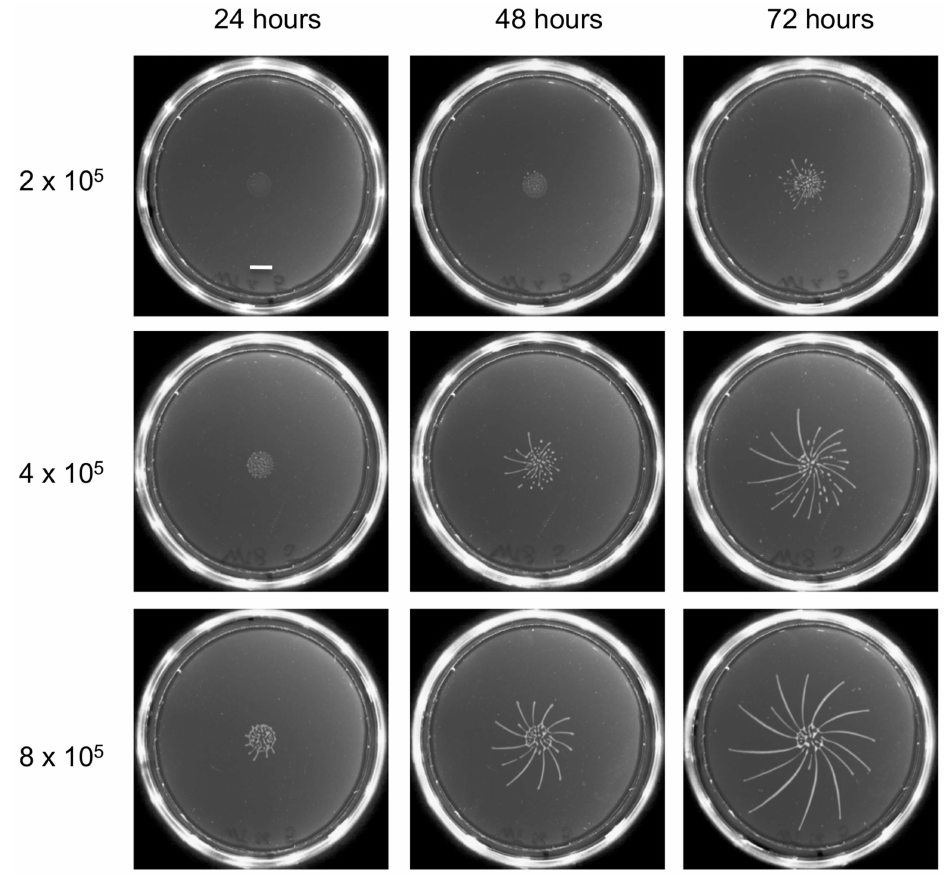
Figure 1. The time-point of migration is density dependent. Different numbers of early procyclic forms of AnTat 1.1 were resuspended in 5 m l and pipetted onto 0.4% agarose plates. Photographs of the plates were taken every 24 h. The scale bar is 1